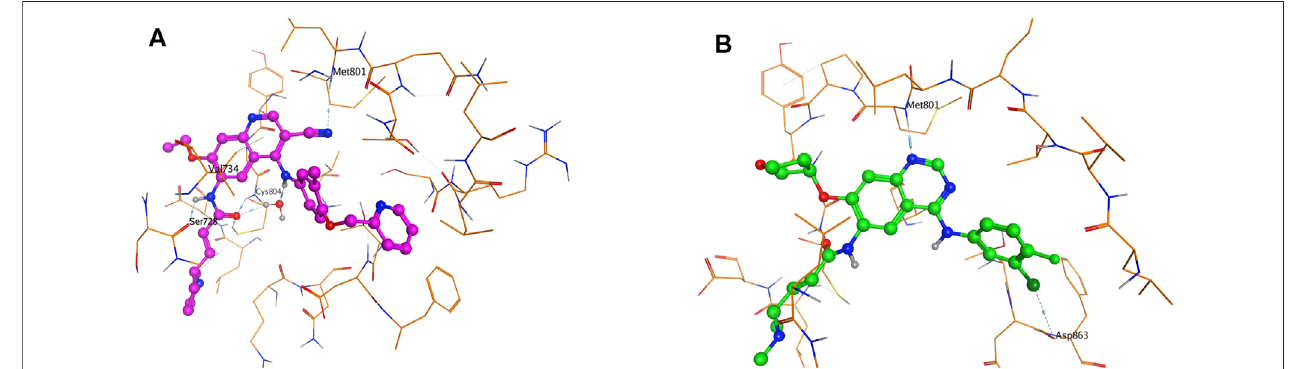
FIGURE 4 | Drug binding modes of afatinib (A) and pyrotinib (B) for A775_G776insYVMA conformation.